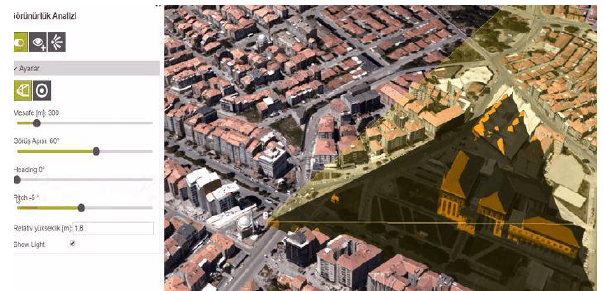
Figure 12. Classification of Storey Usage for Independent Unit Storey usage for independent unit is also important for Disaster and Emergency Management. Storeys above ground can be found from the 3D Geodatabase as seen on Figure 13.